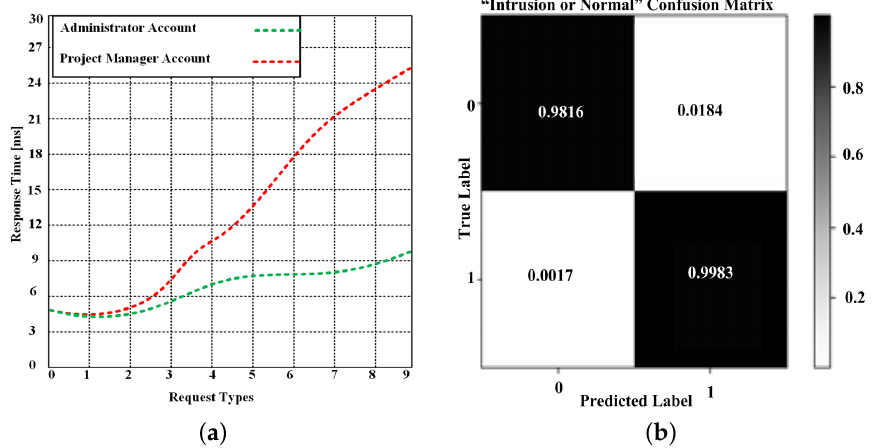
Figure 5. ( a ) Time required for administrator and project manager accounts. ( b ) Confusion matrix of the classification model.